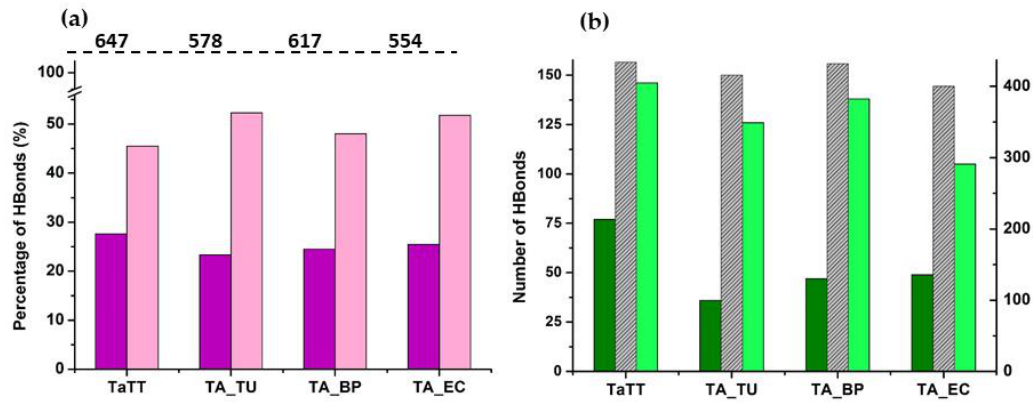
Figure 5. Bar graphs showing the number of hydrogen bonds in functional dimers of TaTT (PDB ID: 6GKR) and its homologs: TA_TU from Thermoproteus uzoniensis ( Toptm in the standard assay is 95 °C [42], PDB ID: 5CE8, ), TA_BP from Burkholderia pseudomallei ( Toptm is unknown, the organism grows optimally at 40 °C, PDB ID 3U0G) and TA_EC from Escherichia coli ( Toptm in the standard assay is 37 °C [43], PDB ID 1I1K). ( a ) Percentage of Surface–Surface (violet) and Inside–Inside (pink) hydrogen bonds in the total number (100%, underlined by dash line) of hydrogen bonds in the dimers; ( b ) Number of Charged–Charged hydrogen bonds (green, left axis), Charged–Neutral (light-green, left axis) and Neutral–Neutral (grey, right axis) hydrogen bonds in the dimers.